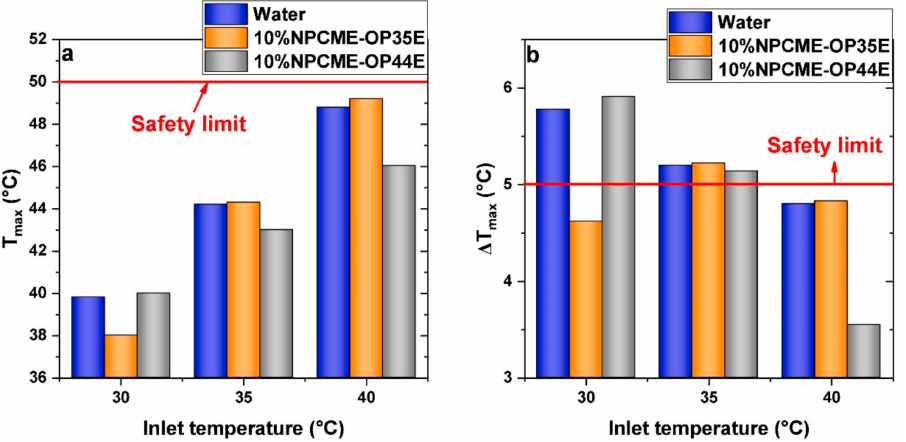
Figure 12. Comparison of T max ( a ) and ∆ T max ( b ) with different inlet temperatures of cooling fluid at 9C discharge and 10 L/h flow rate (Reproduced with permission from Ref. [125]. Copyright 2020